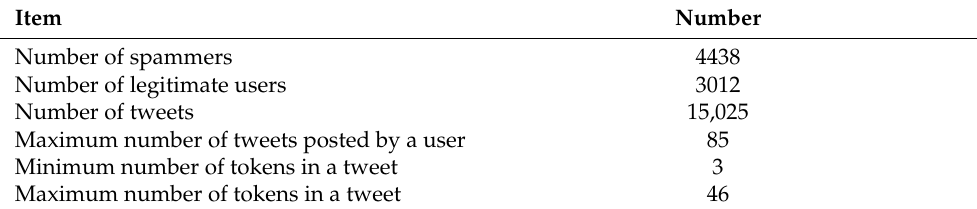
Table 2. Statistics of our